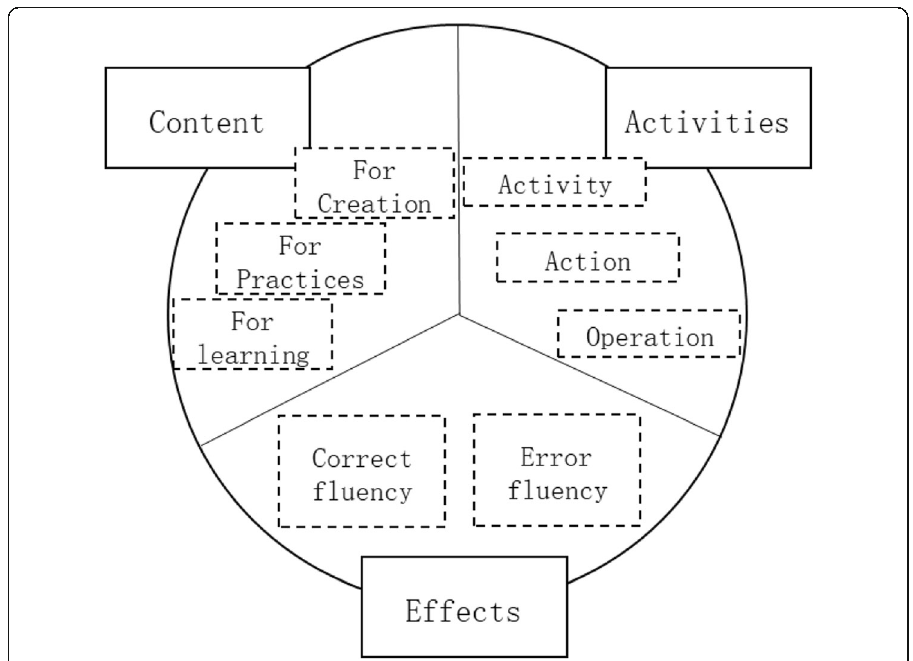
Fig. 5 The internal structure of a learning